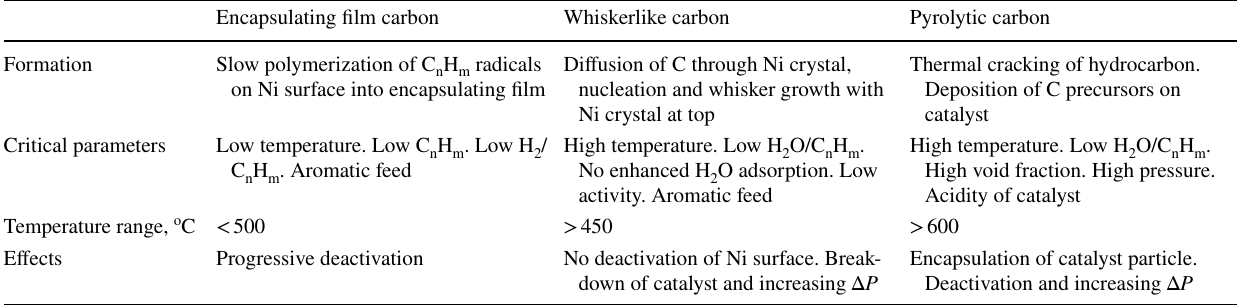
Table 2 Carbon species formed in the steam reforming of hydrocarbons. Reproduced with permission [20]. Copyright 1982, Taylor & Francis